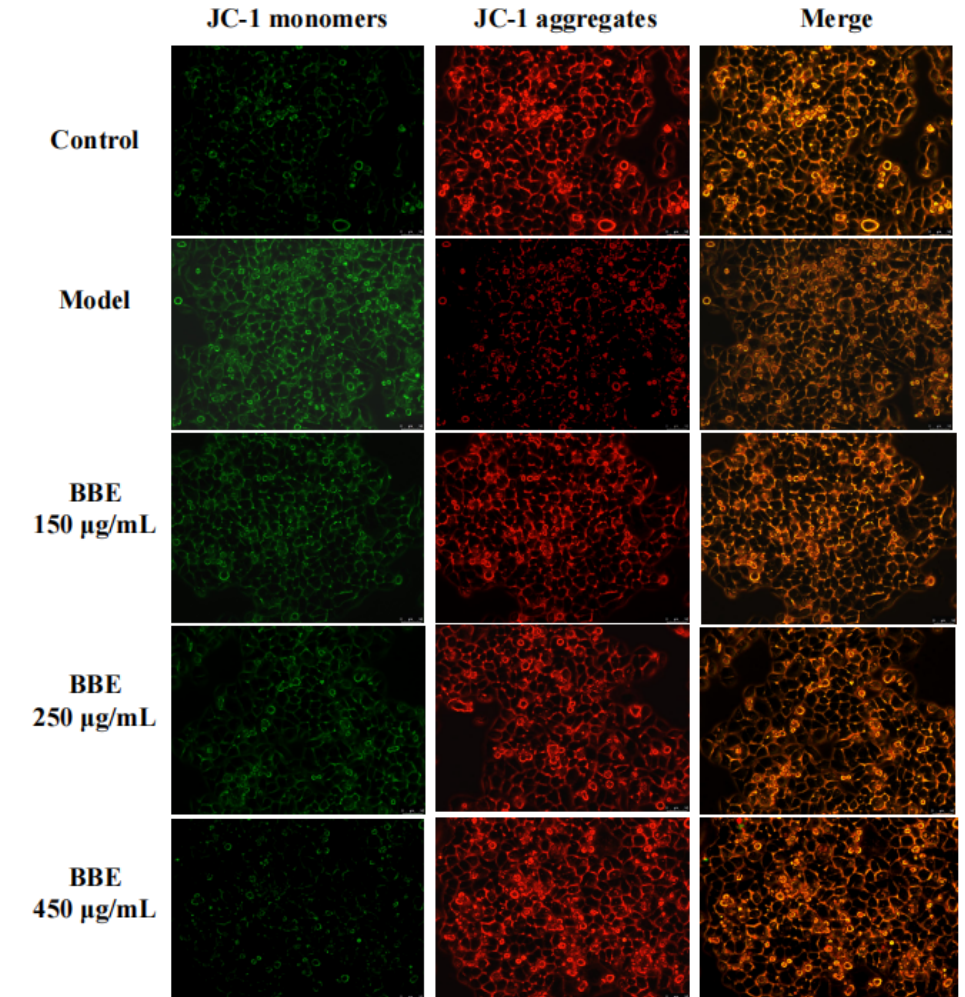
Figure 6. Measurement of mitochondrial membrane potential in HepG2 cells. Cells were stained with JC-1 and visualized on an inverted fluorescence microscope (200 × magnification). Red fluorescence of JC-1 dimers was present in the cell areas with high mitochondrial membrane potential, while the green fluorescence of JC-1 monomers was prevalent in the cell areas with low mitochondrial membrane potential.